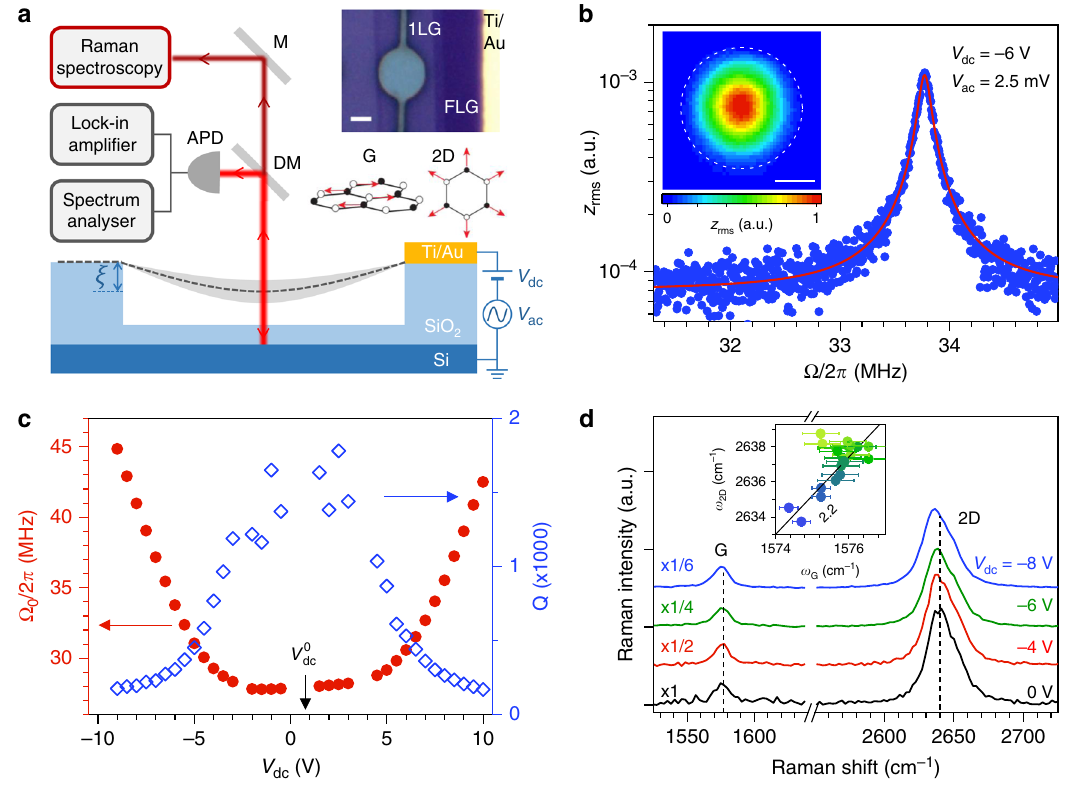
Fig. 1 Experimental setup and characterisation of pristine graphene drums. a Sketch of our experiment combining electrostatic actuation, optical readout of the displacement and micro-Raman spectroscopy of a circular graphene drum (device 1). The graphene layer (with its static displacement ξ ) is represented by the dark grey dashed line; its fl exural motion is sketched with the light grey shade. M, DM, APD represent a mirror, a dichroic mirror, an avalanche photodiode, respectively. Upper inset: optical image of a suspended graphene monolayer (1L) contacted by a Ti/Au lead (scale bar: 2 μ m). A thicker, few-layer graphene fl ake (FLG) is also visible. Lower inset: sketch of the atomic displacements contributing to the Raman G mode and 2D mode. b RMS mechanical amplitude z rms (blue dots) as a function of the drive frequency Ω /2 π at V dc = − 6 V and V ac = 2.5 mV. The red line is a fi t based on linear response theory (Supplementary Note 6). Inset: map of the resonant mechanical (scale bar: 2 μ m). c Resonance frequency Ω 0 /2 π and corresponding quality factor Q as a function of V dc , with V 0 indicating the charge neutrality point in graphene. d Raman spectra measured at the centre of the drum at V dc dc = 0, − 4, − 6, − 8 V and V = 0 mV. Inset: correlation between the G-mode and 2D-mode frequencies ( ω ω ac 2D and G ), extracted from Raman spectra j . The straight black line measured with V dc varying from − 9 V to 10 V. The light green-to-blue colour scale in circles encodes the increase of j V dc (cid:2) V 0 dc with a slope of 2.2 is a guide to the eye corresponding to strain-induced phonon